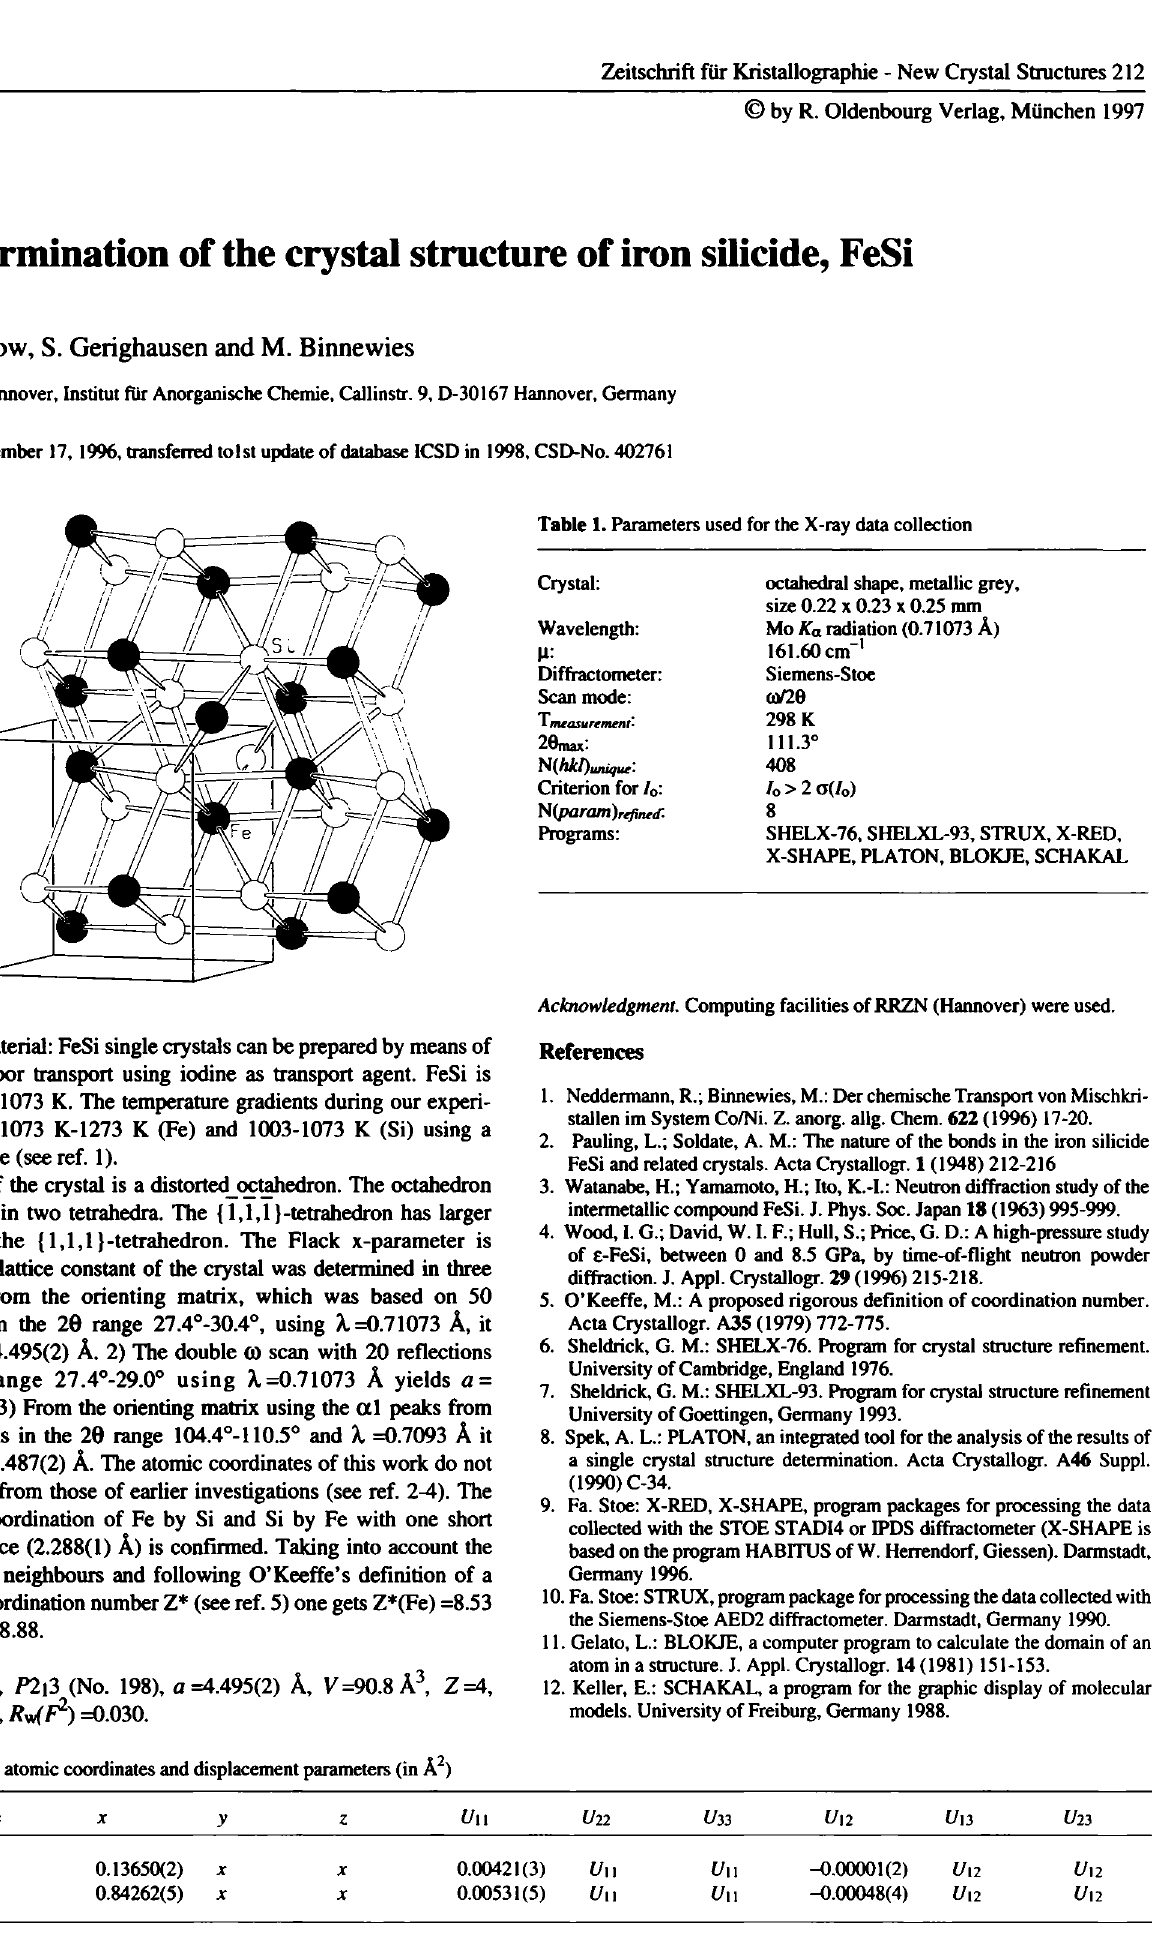
Table 2. Final atomic coordinates and displacement parameters (in Â 2